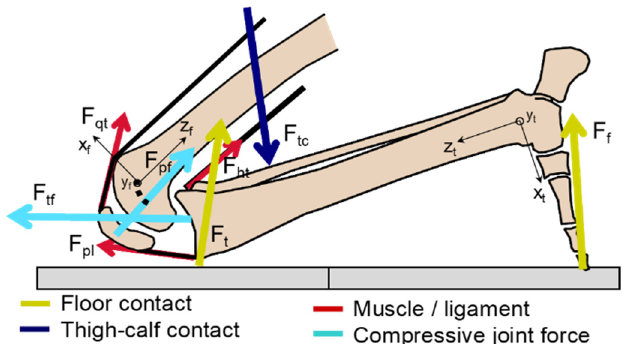
Figure 2. Segments model of the lower limb and applied forces–foot ground contact ( F f ), knee ground contact ( F t ), thigh-calf contact ( F tc ), patellar ligament ( F pl ), quadriceps tendon ( F qt ), hamstrings tendon ( F ht ), tibiofemoral joint ( F tf ), and patellofemoral joint ( F pf ). The inertial and gravitational forces are not explicitly depicted. The local segment coordinate systems of the tibia and the femur are indicated by (x t , y t , z t ) and (x f , y f , z f ), respectively.